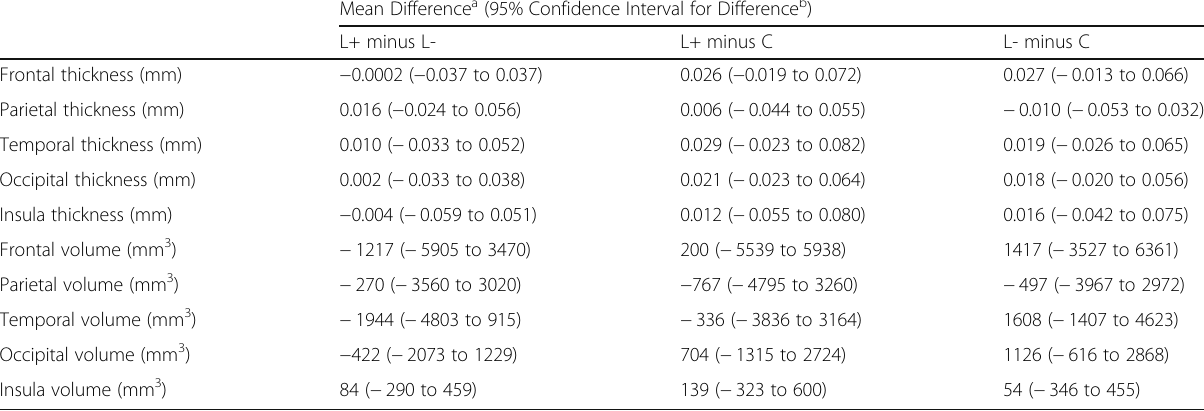
Table 4 Differences in marginal means and 95% confidence intervals Mean Difference a (95% Confidence Interval for Difference b